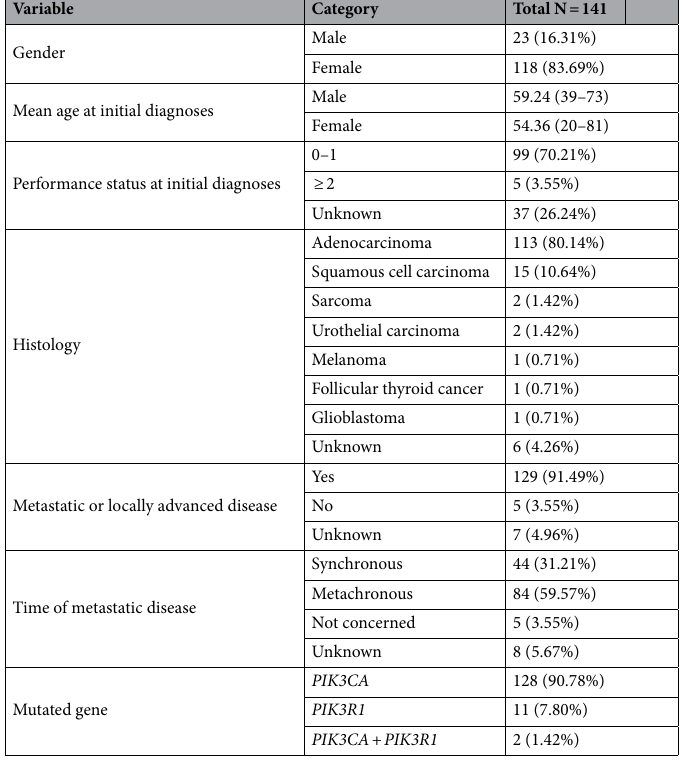
Table 1. Patients’